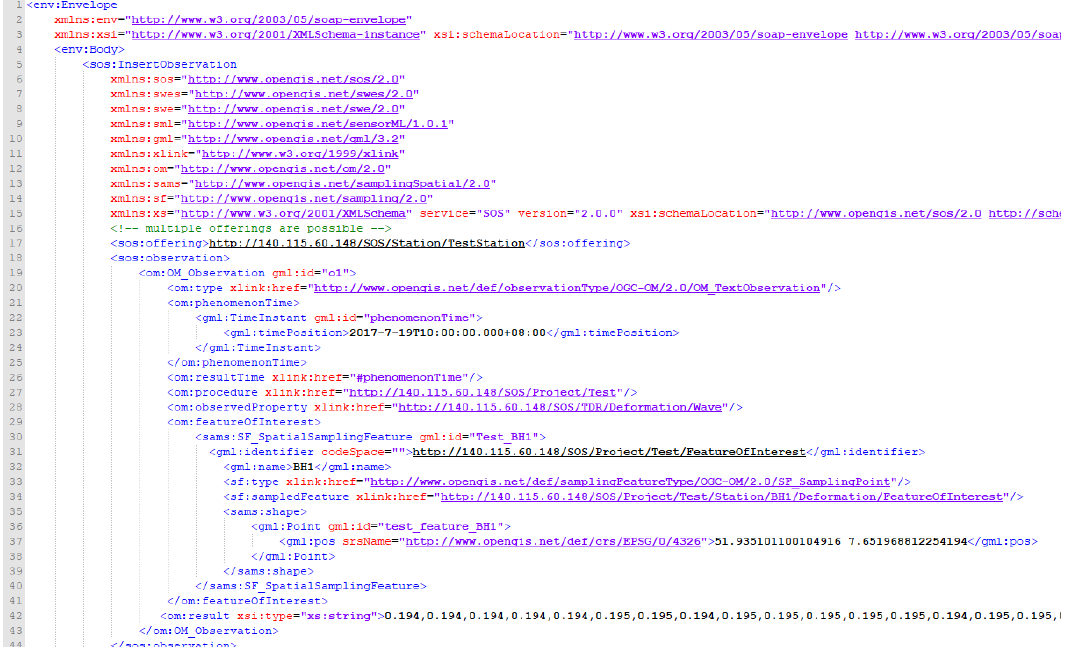
Figure 16. Insert Observation XML request of TDR_Deformation_Observation (Part I).